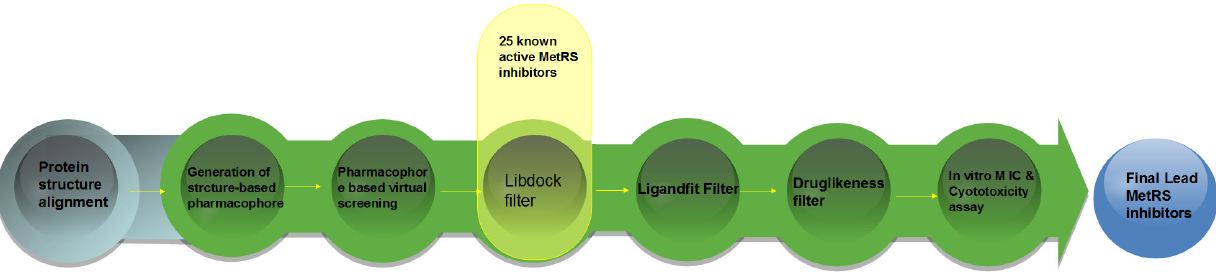
Figure 4. Steps of the generation of the structure-based pharmacophore model and the hybrid virtual screening approach based on structure-based pharmacophore model and molecular